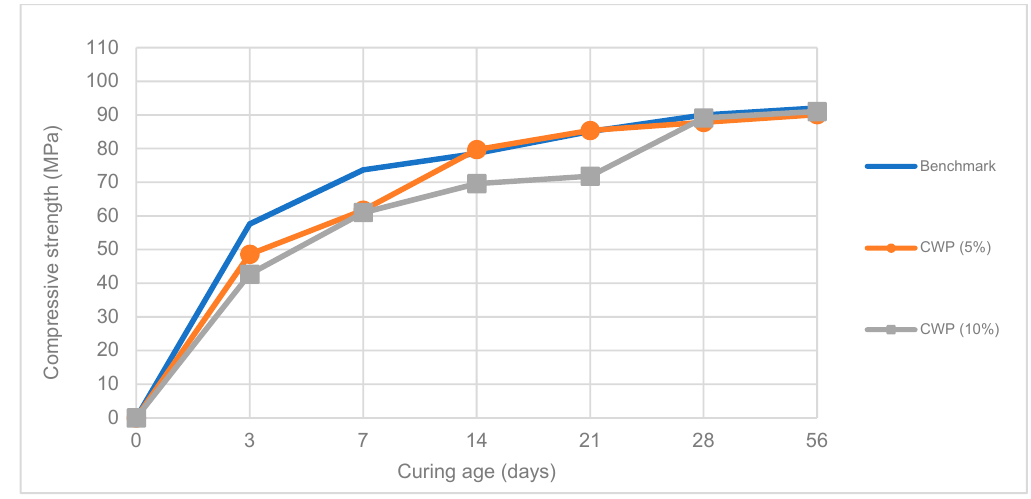
Figure 9. Compressive strength variation of samples containing various doses of CWP.